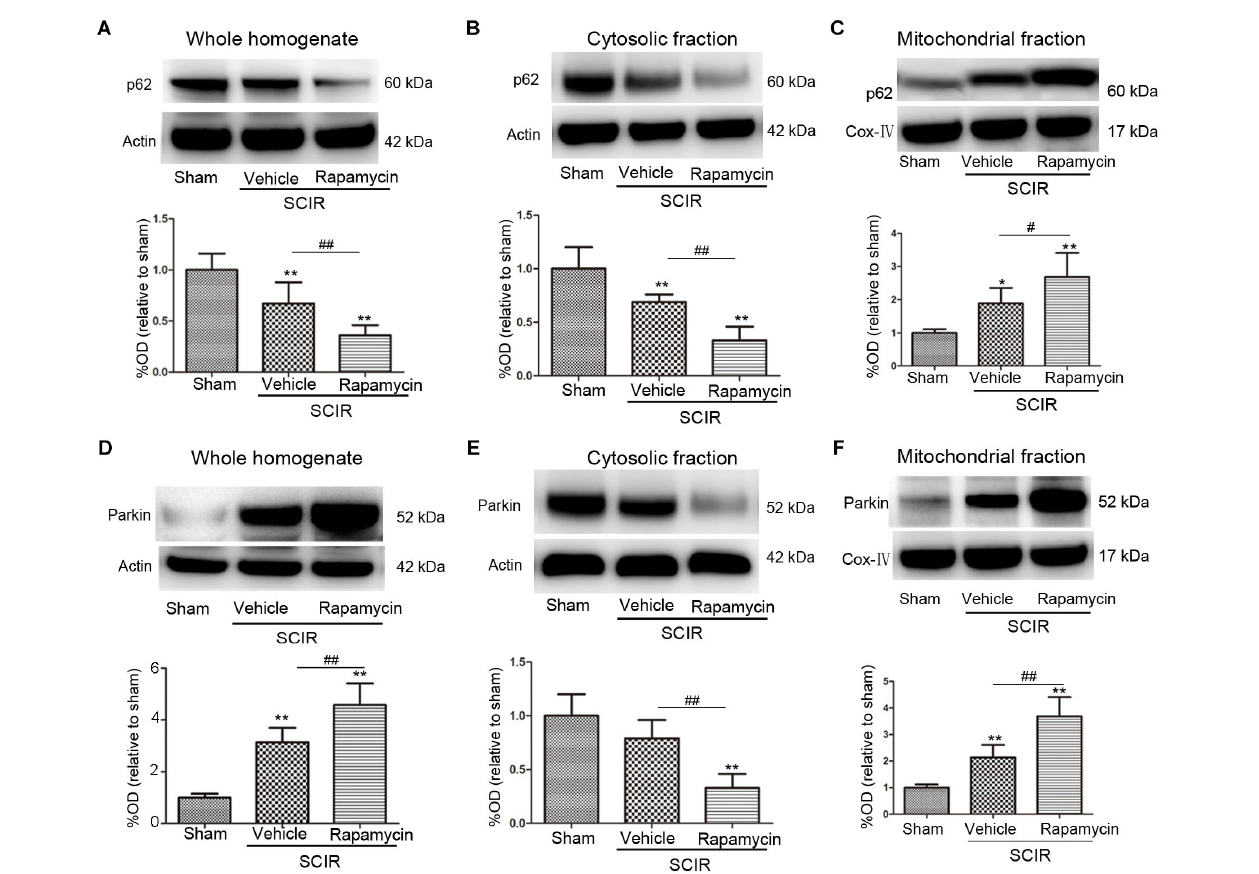
FIGURE 2 | Rapamycin enhanced mitophagy via promoting p62, Parkin translocation to the mitochondria. (A–C) Representative western blots and quantitative graphs demonstrate the expression of p62 in the whole homogenates, in the cytosolic fractions and in the mitochondrial fractions at 24 h after SCIRI. Data were shown as mean ± SD, n = 6. ∗ p < 0.05, ∗∗ p < 0.01 vs; Sham, # p < 0.05, ## p < 0.01. (D-F) Representative western blots and quantitative graphs demonstrate the expression of Parkin in the whole homogenates, in the cytosolic fractions and in the mitochondrial fractions at 24 h after SCIRI. Cox- IV is as inner control for mitochondria protein, β -actin is as inner control for tissue homogenate protein. Data were shown as mean ± SD, n = 6. ∗ p < 0.05, ∗∗ p < 0.01 vs. Sham; # p < 0.05, ## p <